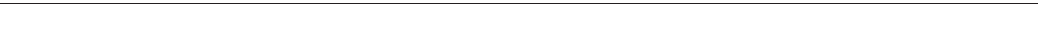
Fig. 1 Identi fi cation of newly formed SecGFP-GPI endocytic vesicles using a pH pulsing assay. a Schematic (top panel) of the pH pulsing assay depicting the effect of pH on SecGFP-GPI fl uorescence during endocytic vesicle budding. Note the fl uorescence of SecGFP-GPI is retained at high pH (top and bottom left panel) or when exposed to low pH if sequestered in a newly formed endocytic vesicle (bottom right panel), and quenched only when exposed to low pH (top right panel). Sequential TIRF images of AGS cell co-expressing SecGFP-GPI and mCherry-ARF1 collected at pH 7, pH 5 and in the RFP channels (middle panel). Newly formed endocytic vesicles (inset) (identi fi ed as in Supplementary Figure 1c) are used to construct a single frame (yellow rectangle) of the montage depicted (bottom panel). b Average of the normalised fl uorescence intensities of pH 5 and pH 7 traces at the site of newly formed SecGFP- GPI endocytic vesicles compared to their respective random traces constructed from 120 endocytic events (pH 5 and pH 7) and 3428 random spots, derived from 17 cells pooled from four independent experiments. c The graph shows the fold enrichment of fl uorescence intensity over the local background of pH 5 vs. pH 7 at the time of formation of the endocytic vesicles (data from 1b). d – f Graphs show the average normalised fl uorescence intensity vs. time traces for the recruitment of TagRFPt-CDC42 ( d ), mCherry-ARF1 ( e ) and mCherry-GBF1 ( f ) to the forming SecGFP-GPI endocytic sites, and its corresponding random intensity trace ( n , Table 1). The random traces were derived from randomly assigned spots of the same radius as the endocytic regions, as detailed in S.I. Endocytic distribution at each time point was compared to the random distribution by Mann – Whitney U test, and the log 10 (p) [log 10 (0.05) is − 1.3 and log 10 (0.001) is − 2.5] is plotted below each trace ( d – f ). Representative montages from the respective data sets are depicted below the graphs ( d – f ). Arrowheads indicate the newly formed endocytic vesicle. Error bars, s.e.m. ( b , d – f ). Scale bar, 1.5 µ m ( a , d – f